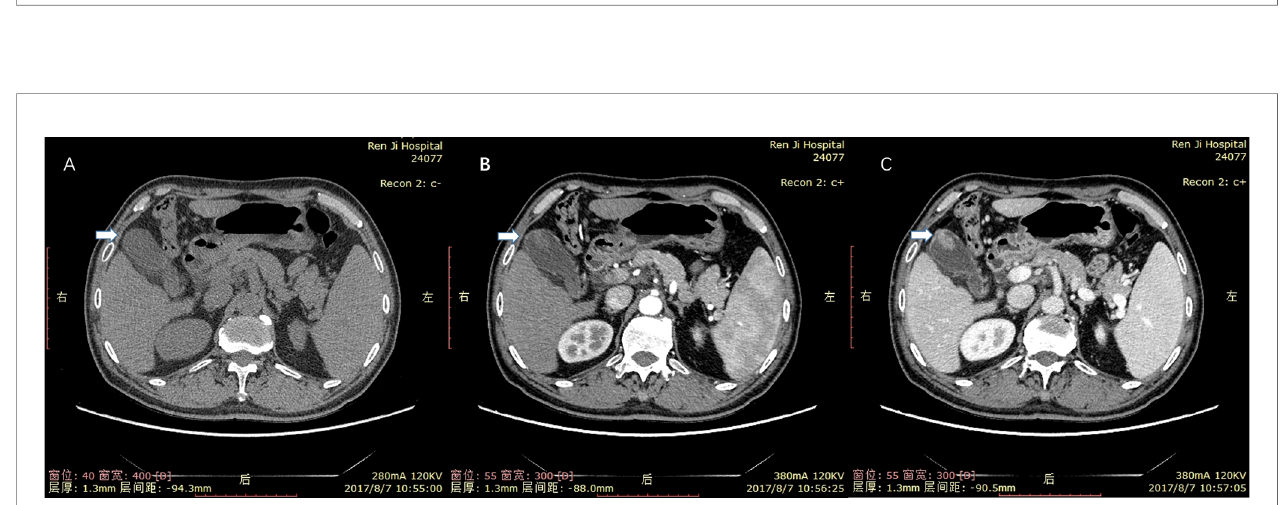
FIGURE 5 | Cholesterol polyp measuring 22 mm in diameter in a 51-year-old man. Right, Conventional sonogram 2D mode (arrow). Left, Microvascular image of CEUS showing intralesional vessels with a strong and heterogeneous pattern. (arrow). So it was mistaken as gallbladder cancinoma.